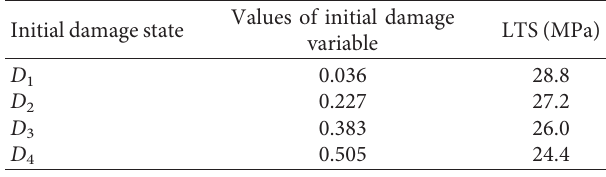
Table 5: LTS value of the rock specimens obtained by methods